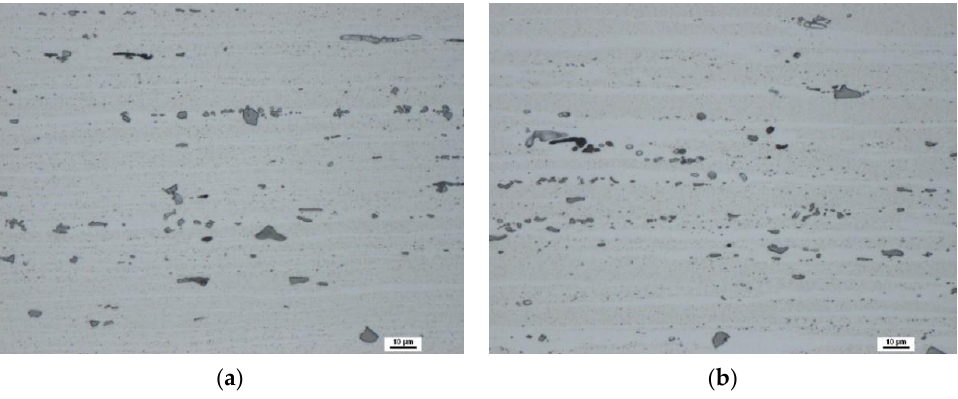
Figure 6. Electron micrographs of the QS material taken in the LR section: ( a ) surface region; ( b ) central region. Dix–Keller etching was used for revealing